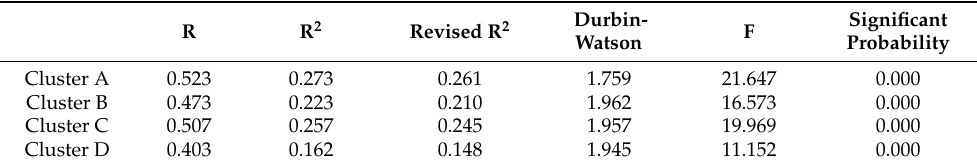
Table 3. Model explanatory power and suitability analysis